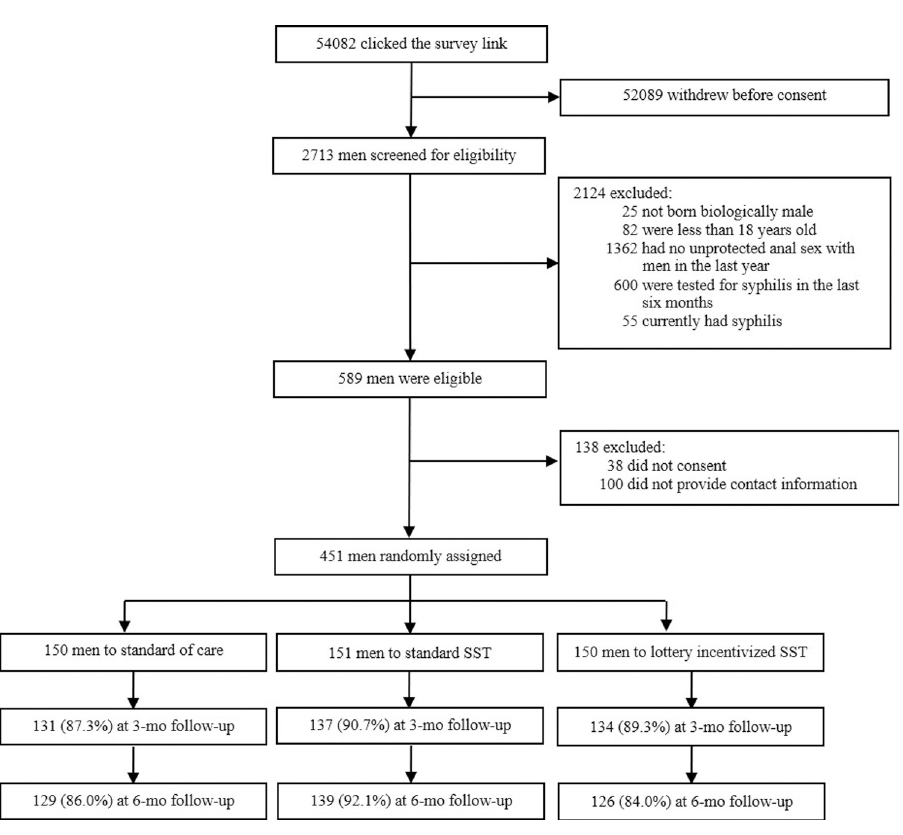
Fig 2. CONSORT flowchart. CONSORT, Consolidated Standards of Reporting Trials; SST, syphilis self-testing.